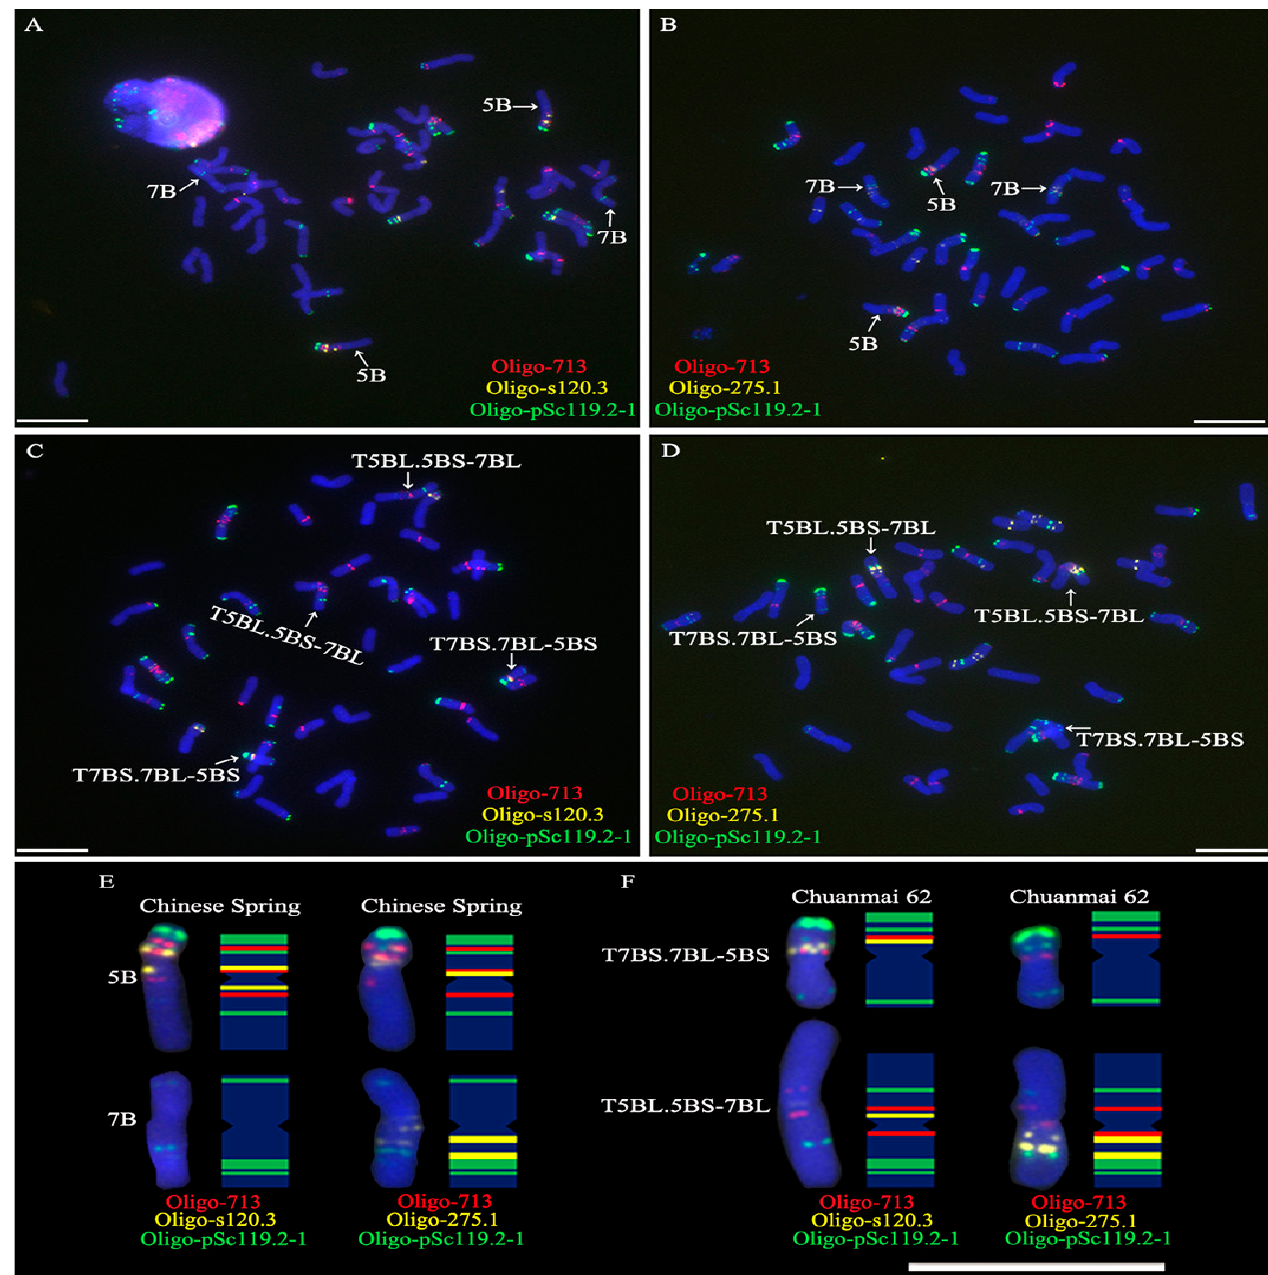
Figure 1. FISH analysis of root-tip metaphase chromosomes of Chinese Spring and Chuanmai 62 using oligo probes Oligo-713 (red), Oligo-s120.3 (yellow), Oligo-275.1 (yellow), and Oligo-pSc119.2-1 (green). ( A , B ) Cells of Chinese Spring. ( C , D ) Cells of Chuanmai 62. ( E , F ) Cut-and-paste chromosomes 5B of Chinese Spring and the translocations T5BL.5BS-7BL/T7BS.7BL-5BS of Chuanmai 62. The ideograms of these chromosomes are also exhibited. Scale bar: 10 μ m and 50 μ m.